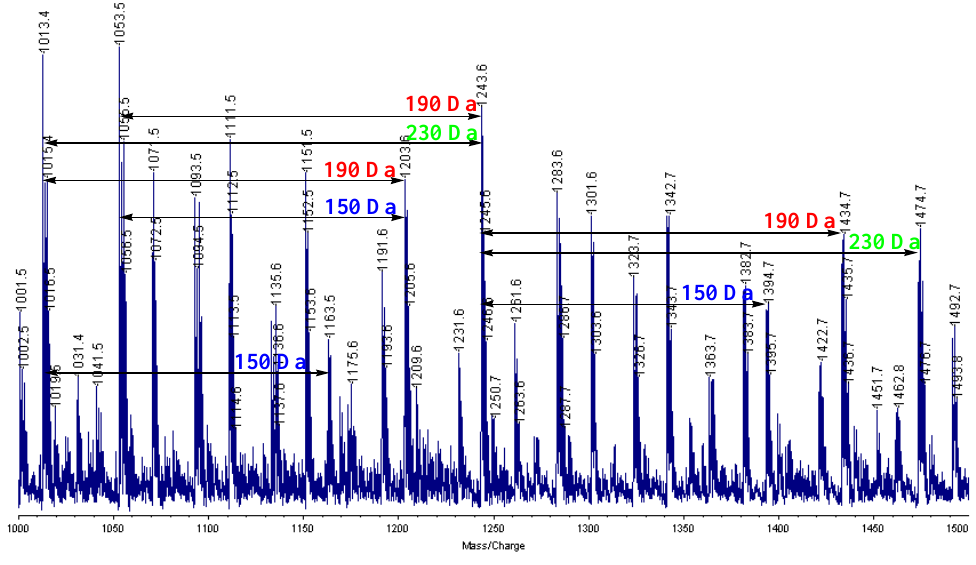
Figure 6 . MALDI-TOF mass spectrum of polymer 1 .